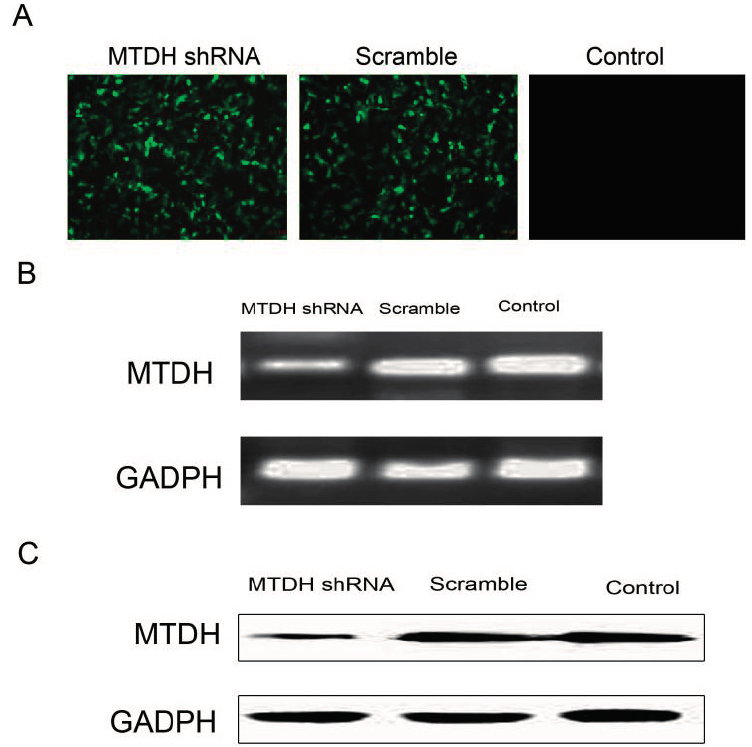
Figure 2. shRNA silencing of MTDH expression effectively reduces MTDH mRNA and protein expression in HepG2 cells. ( A ) Stably transfected HepG2 cells on fluorescence microscopy (200×); ( B ) q-PCR quatification of MTDH mRNA, and products were observed with 1.5% agarose gel containing 0.5 μ g/mL ethidium bromide with an ultraviolet illuminator; ( C ) Western blot to test MTDH protein